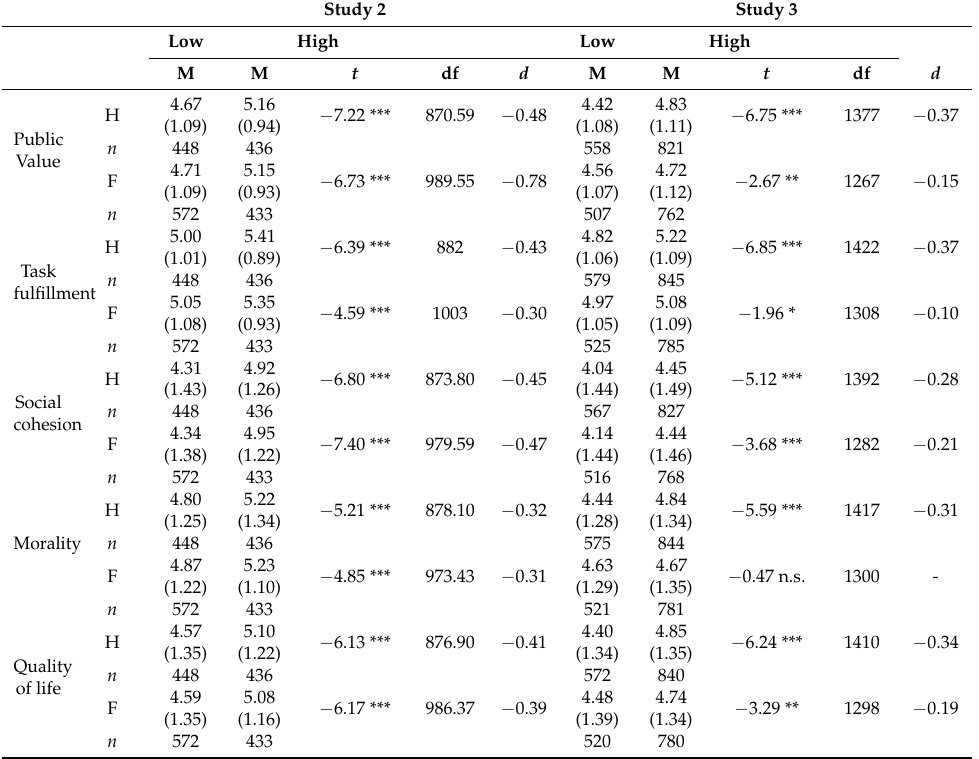
Table 10. Results of Independent Samples t -Tests of Hedgehogness and Foxiness Means of Respondents for the Overall Public Value of the Employing Organization and Each Public Value